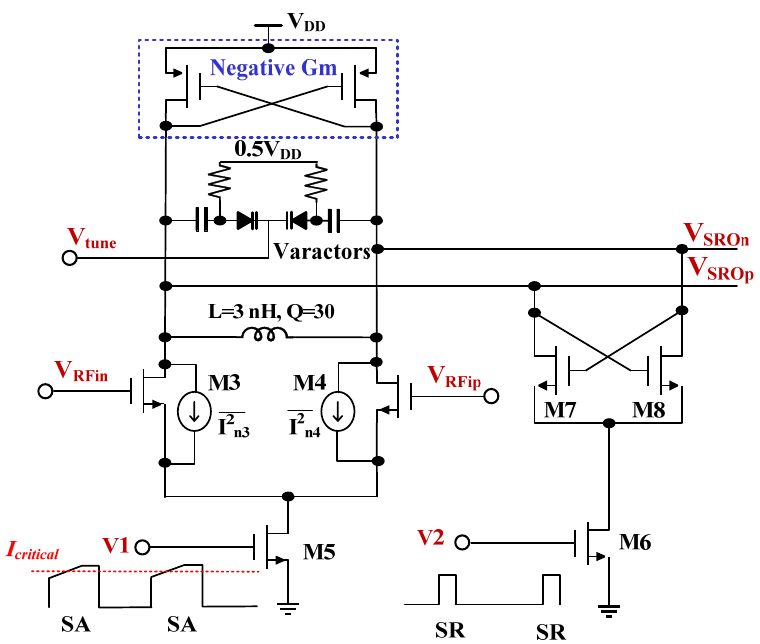
Figure 10. The proposed SRO architecture with CQW technique.